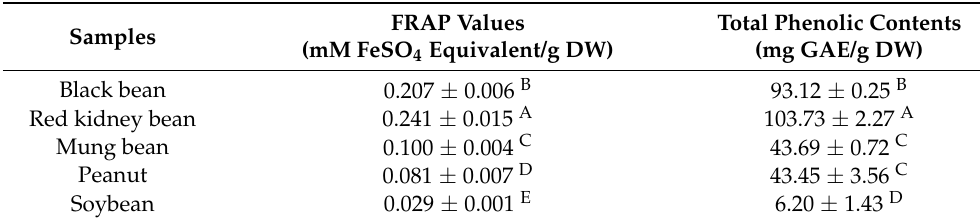
Table 5. Ferric reducing antioxidant power (FRAP) values and total phenolic contents (TPCs) of each bean milk.